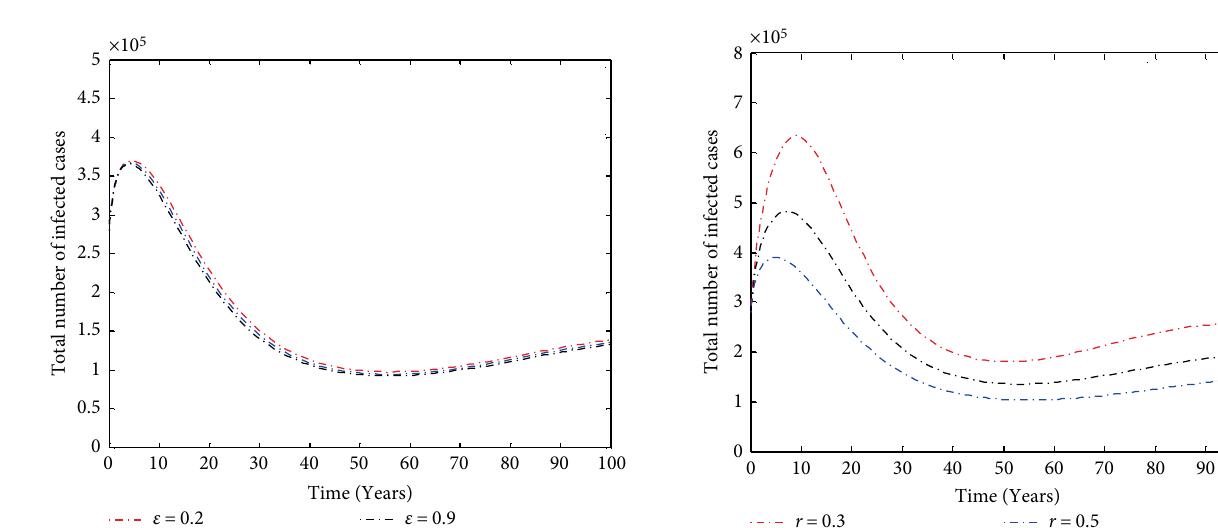
Figure 4: The plot shows the effect of transmission coefficient on the total number of infected class.